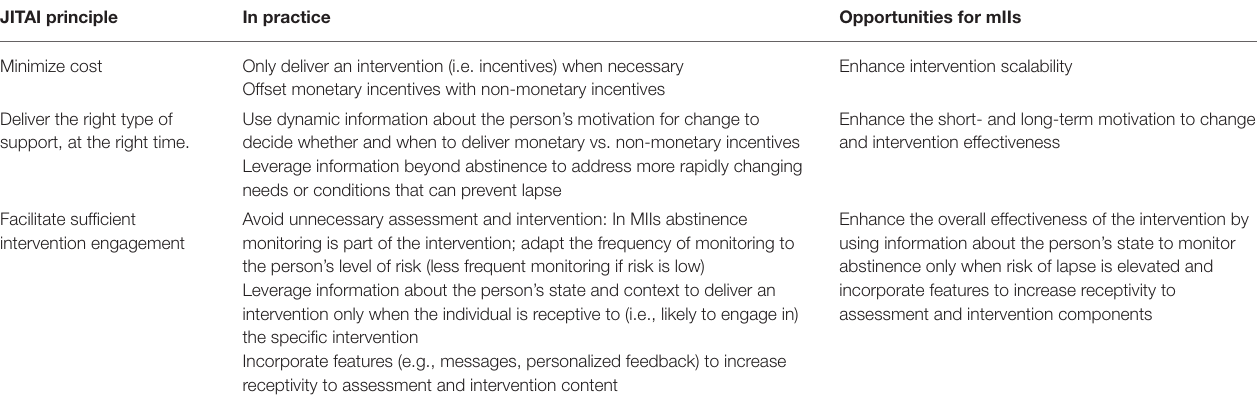
TABLE 1 | How JITAI principles can inform a new era of MIIs for smoking cessation. JITAI principle In practice Minimize cost Only deliver an intervention (i.e. incentives) when necessary Offset monetary incentives with non-monetary incentives Deliver the right type of support, at the right